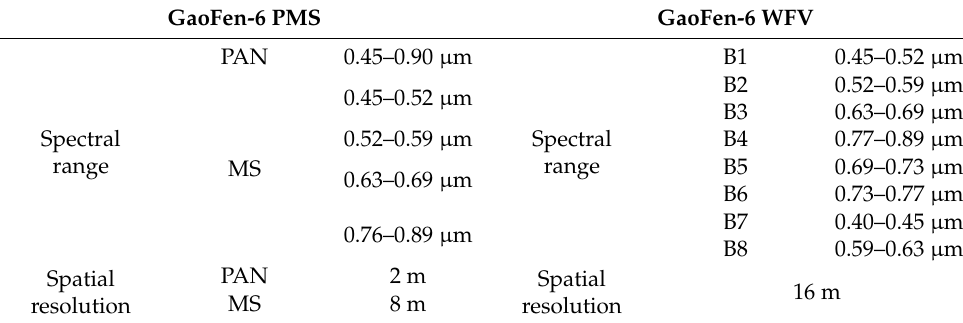
Table 1. GaoFen-6 spectral parameters.